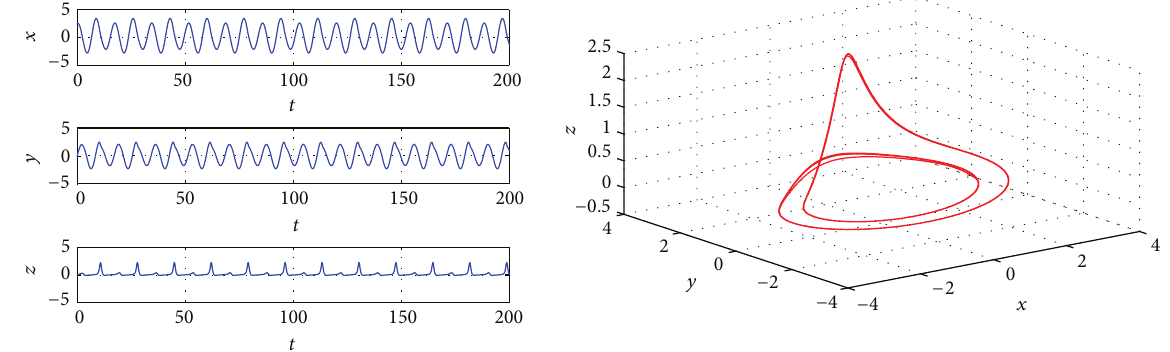
Figure 3: The trajectories and phase graphs of system (61) with 𝜏 = 0.7362 when 𝐾 = −1 .